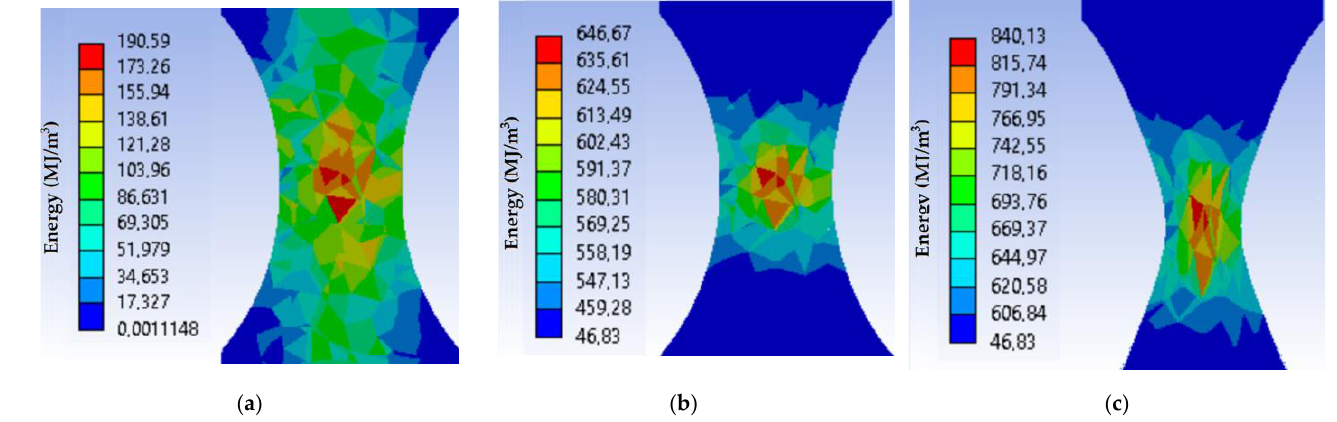
Figure 9. Strain energy distribution in the sample during its loading under the load mode I: ( a ) when the equivalent stresses reach the yield strength; ( b ) when the equivalent stresses reach the ultimate strength; ( c ) at the fracture moment.